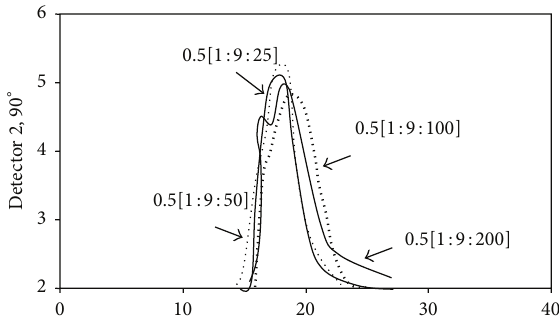
Figure 2: Effect of TIBA on weight-average molecular weight.